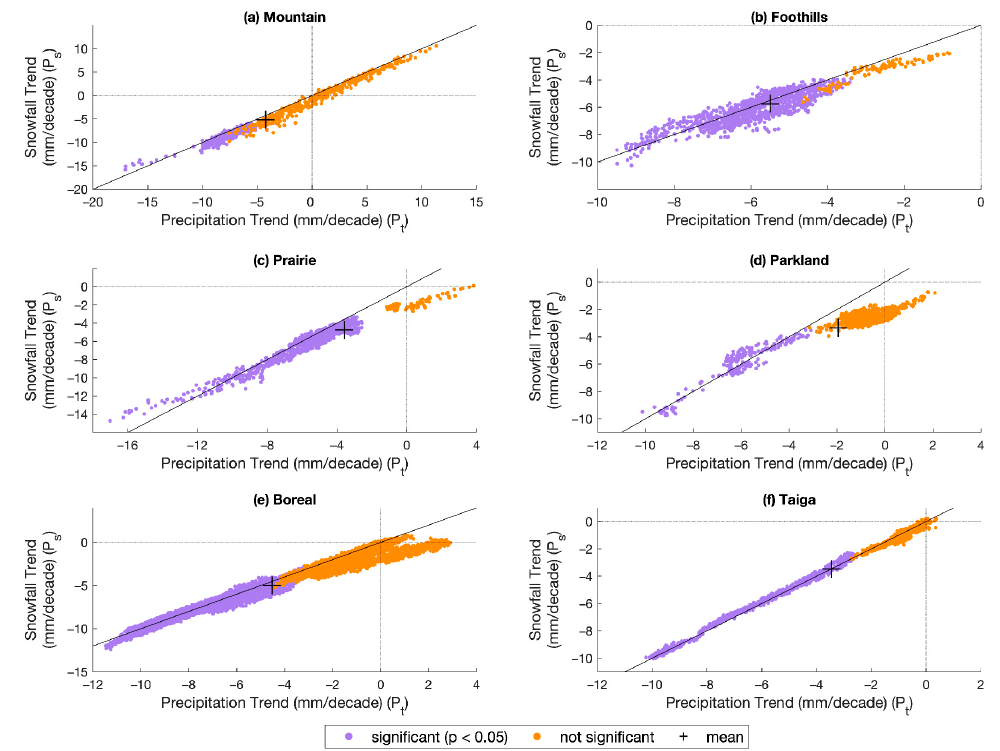
Figure 3. Trends in total November–April precipitation (x-axis) and precipitation falling as snow (y-axis) as determined through a temperature index rain–snow equation over the historic period (1950–2017). Points on the graphs represent ANUSPLIN grid points, at ~10 km resolution, within each ecozones and ecozone-averaged trends are indicated by a black plus sign (+). Reference lines represent equal precipitation and snowfall trend magnitude (P t = P s ).